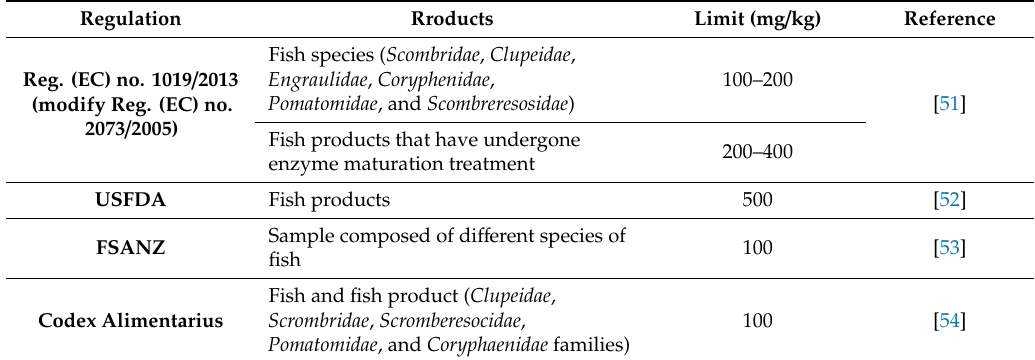
Table 2. Concentration limit of histamine in di ff erent